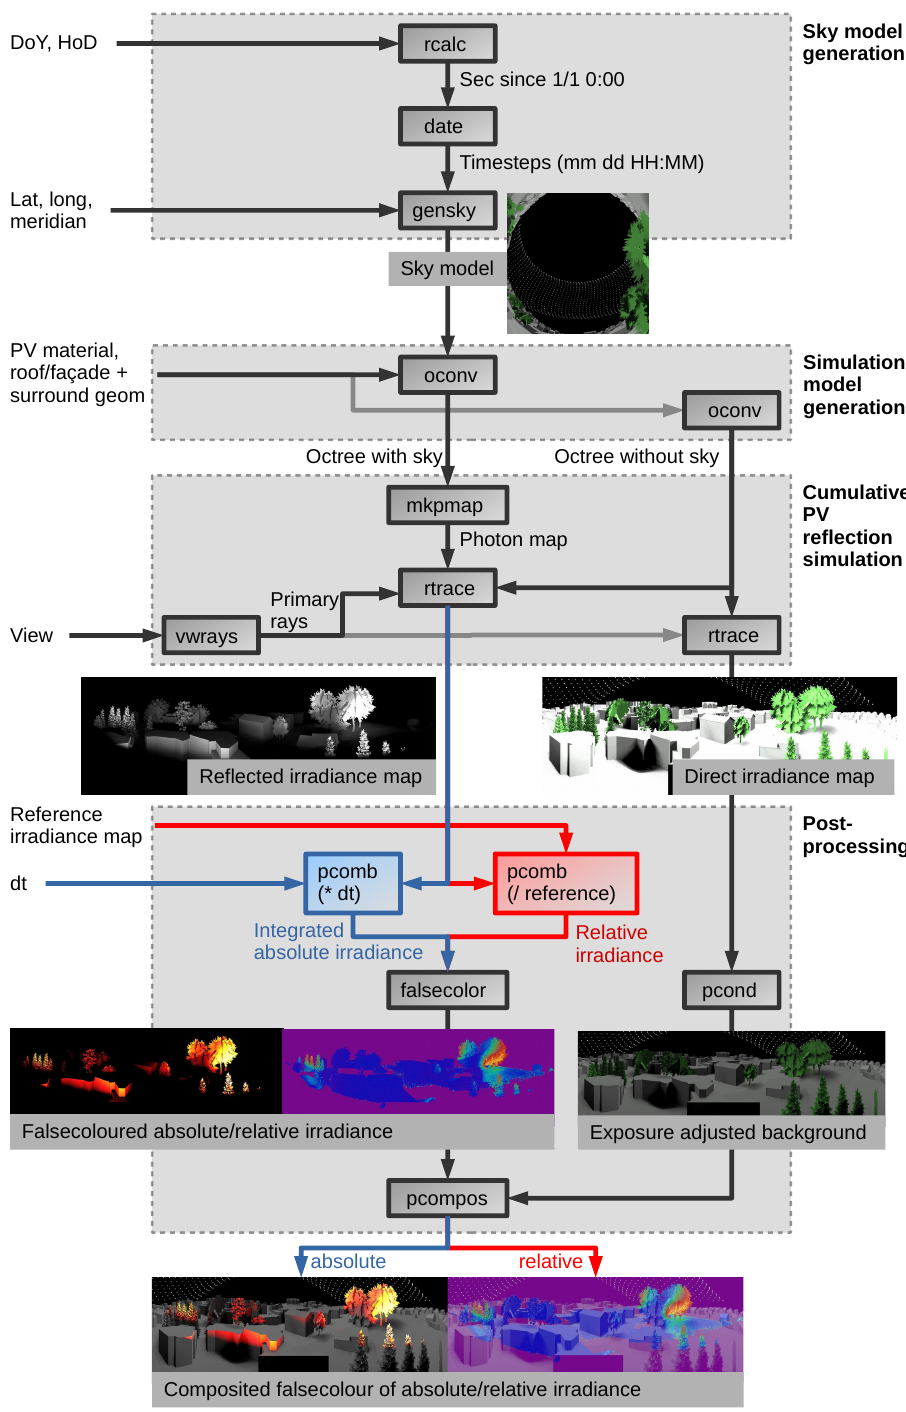
Figure 4. General PV reflection simulation workflow to assess cumulative annual